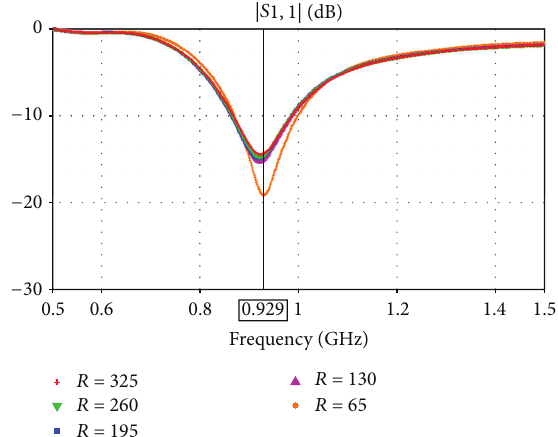
Figure 10: Resonance frequency of five-layers strip dipole antenna with difference overlap length (millimeters).